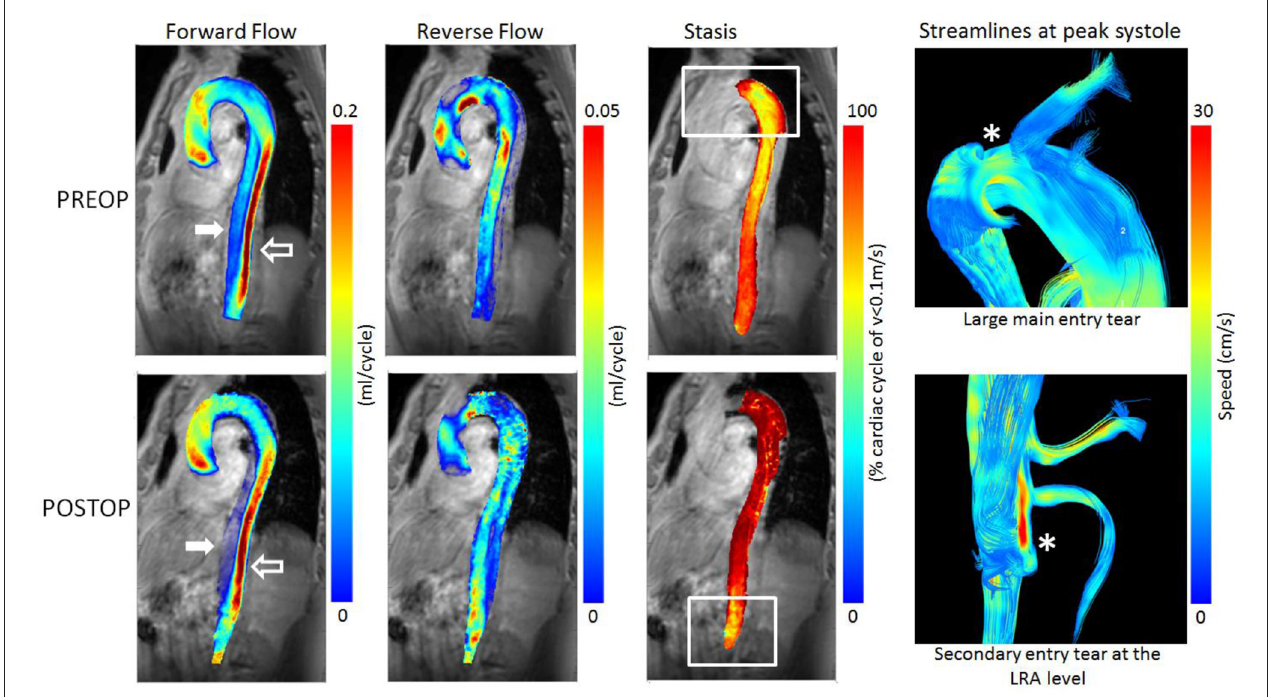
FIGURE 3 | Pre-operative (TOP) and post-operative (BOTTOM) parametric hemodynamic maps of Patient 1 presenting with persistent pain as indication for TEVAR. Forward and Reverse flow maps (Left) are presented for both the true lumen (empty arrow) and the false lumen (white arrow). Forward flow increased in the true lumen and significantly decreased in the false lumen post-TEVAR. Similarly, reverse flow increased in the true lumen and decreased in the false. Reverse flow can also be observed in the ascending aorta indicating a recirculation region, both pre and post-op. To be noted, the local high reverse flow at the LRA level post-TEVAR that may indicate a hemodynamically significant secondary tear. Stasis maps (Center) are presented for the false lumen only to avoid confusion from the true lumen, as the false lumen twirls around it. Significant increase in stasis is observed post-TEVAR, except for the lower most region. Importantly, stasis maps facilitated visualization of hemodynamically significant entry tears (*), as confirmed by the streamline visualization (Right).